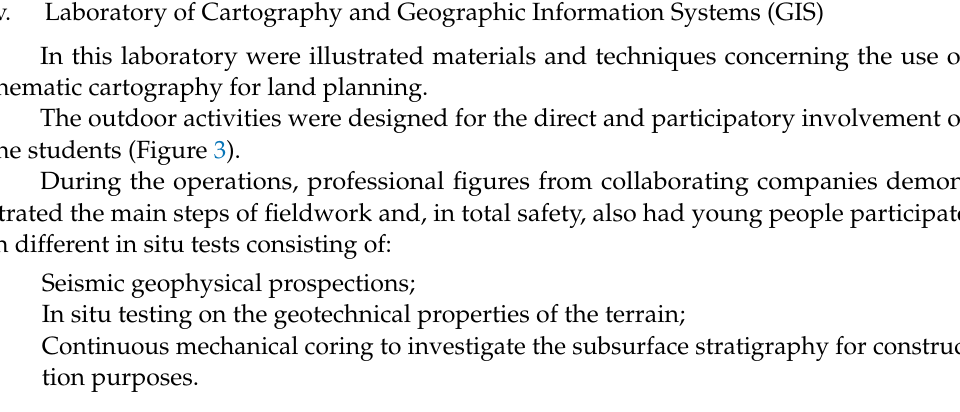
Figure 3. Some examples of outdoor testing: ( a ) students engaged in laying cables and tools for seismic prospecting (year 2016); ( b ) pieces of cores in the cataloging boxes from which students derived the stratigraphic and lithologic information from coring subsoil (year 2016).